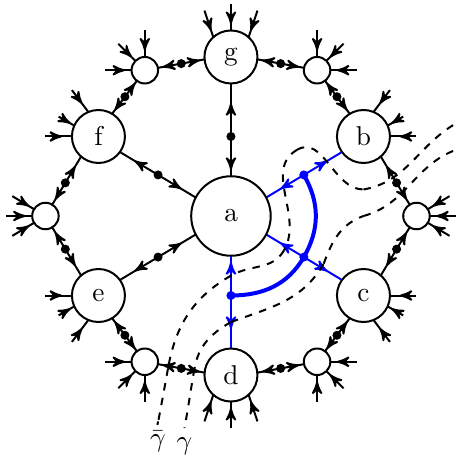
Figure 14. Illustration of how to choose an isometric cut for the subregion consisting of legs adjacent to the d and c vertices. The upper dashed line crosses legs included in the ¯ B Hilbert space, while the lower dashed line crosses legs included in the B Hilbert space. It is straightforward to check that both the operators above and below the dashed lines are isometries; it follows that S ( A ) = 1 2 I ( ¯ B : B